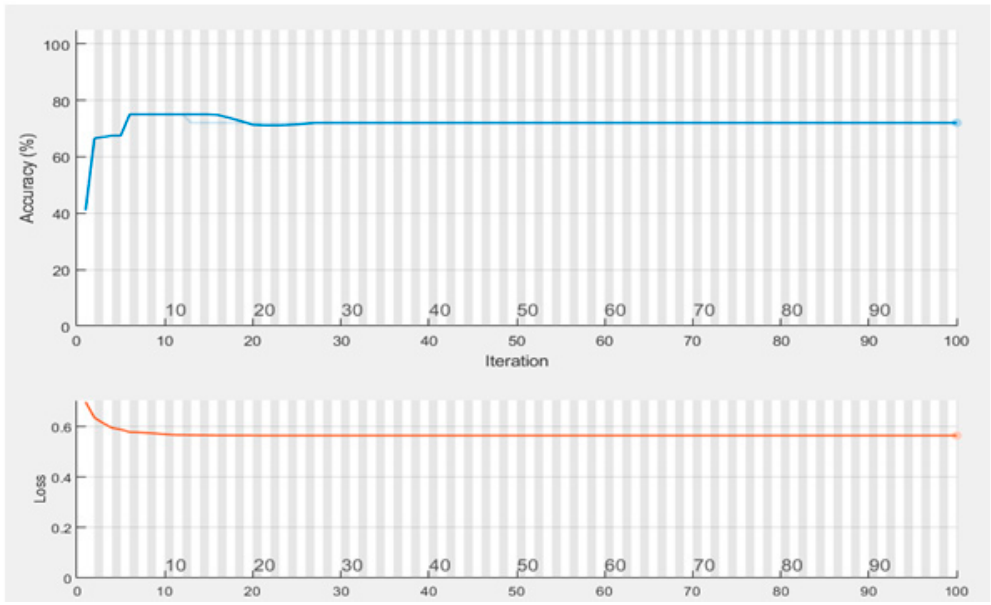
Figure 5. Training progress of the secure GRU-RNN for the HDD dataset.